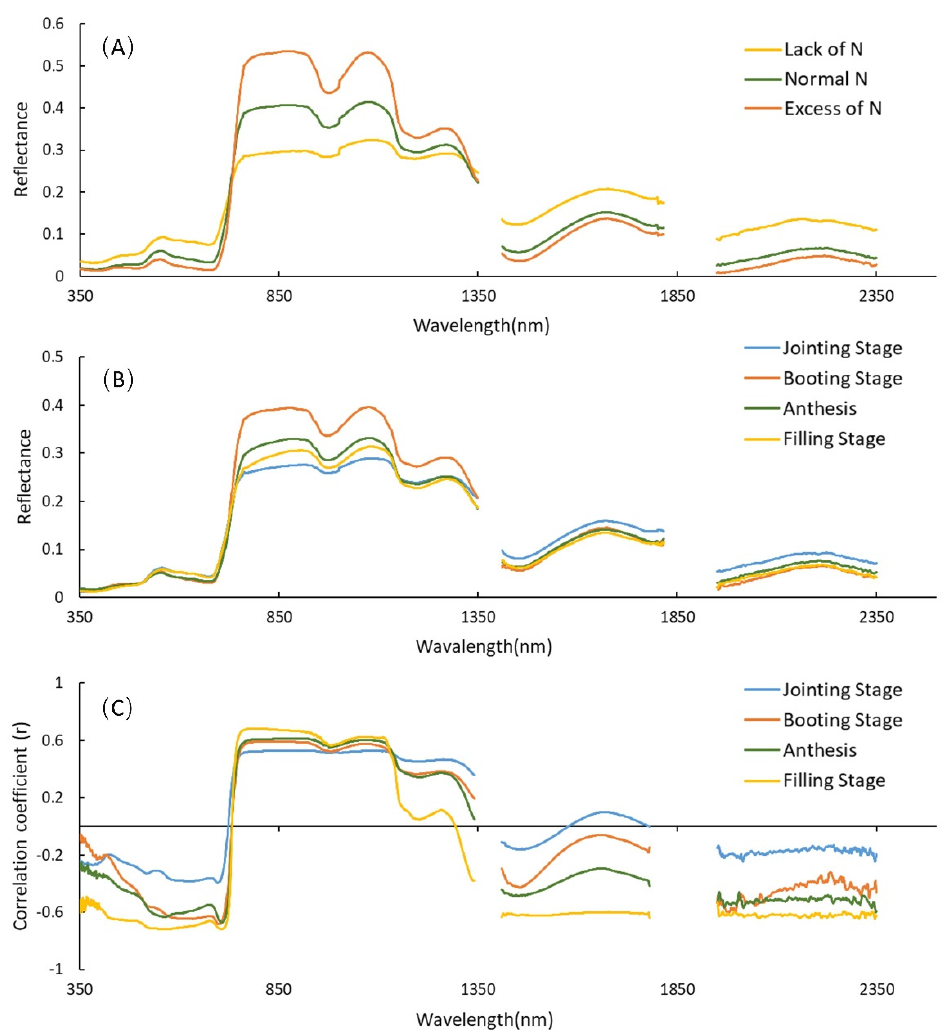
Figure 2. Spectral reflectance properties of the wheat canopy: ( A ) spectral reflectance under N stress; ( B ) spectral reflectance at different growth stages under normal N; and ( C ) correlation between leaf nitrogen concentration (LNC) and spectral reflectance at different growth stages.